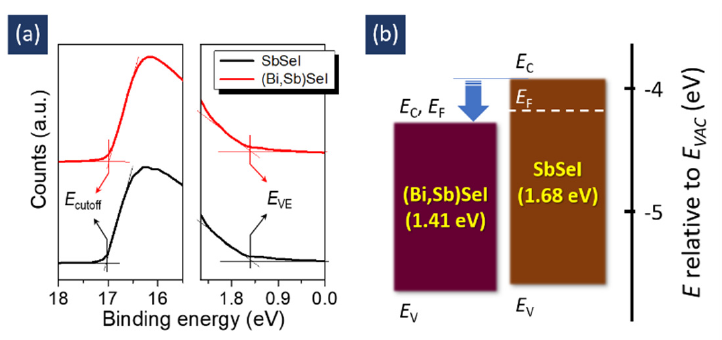
Figure 5. ( a ) UPS spectra of SbSI and (Bi,Sb)SeI, and ( b ) the derived energy level diagram.